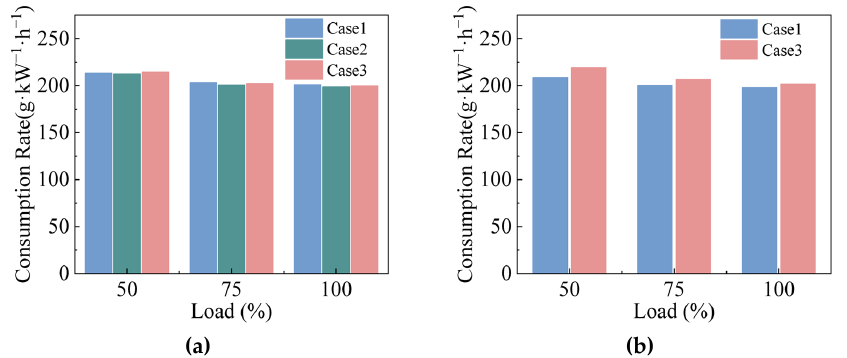
Figure 4. The trend of consumption rate for variable EBP at different loads. (a) EBP = 10 kPa; (b) EBP = 25 kPa. ( b ) EBP = 25